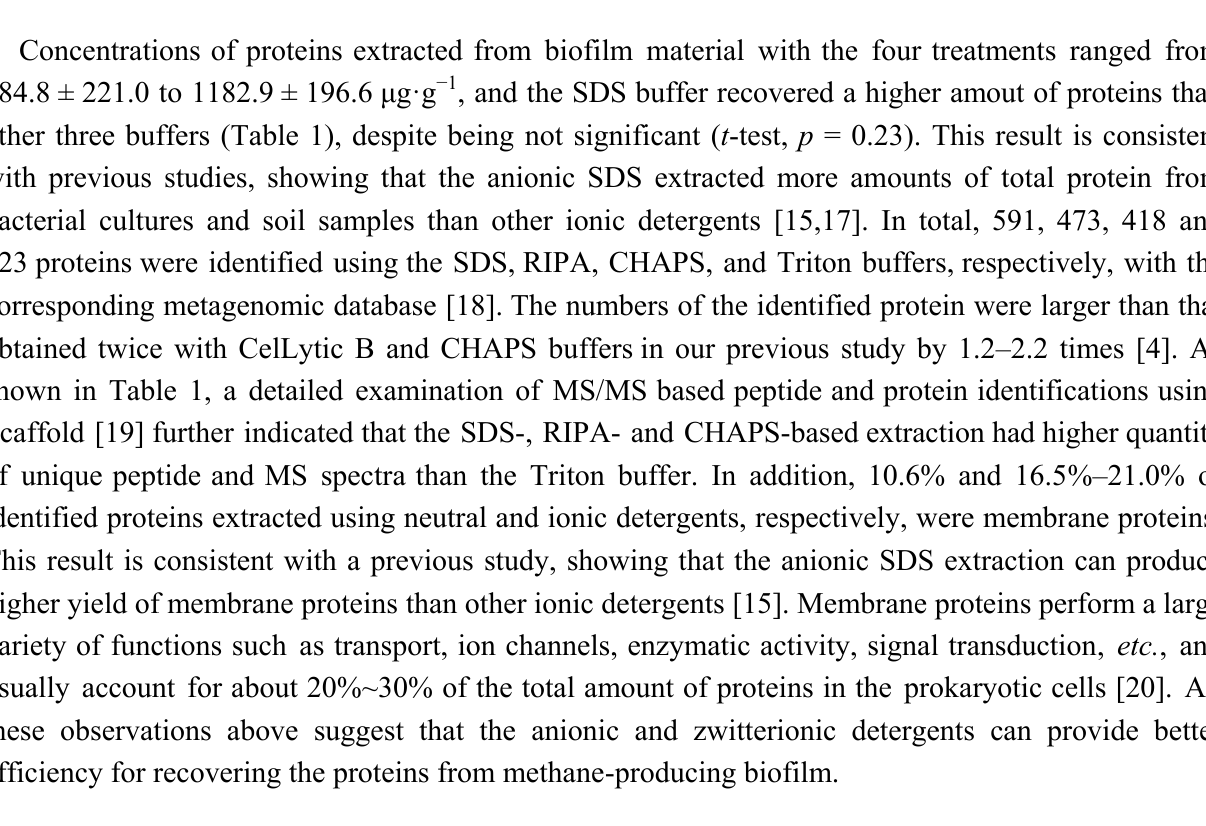
Table 1. Summary of biofilm proteomes obtained using different extraction